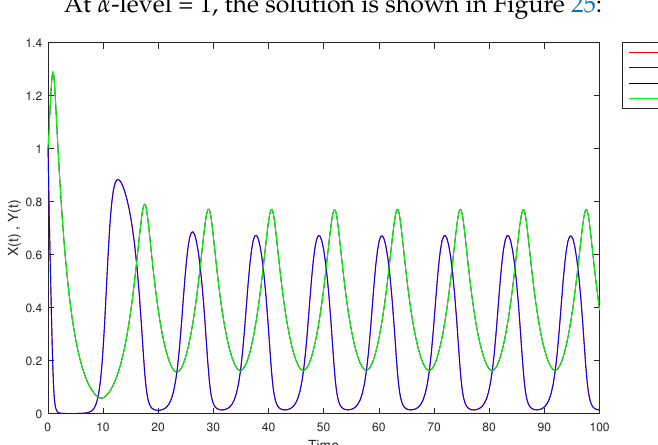
Figure 25. The solution of (12) at α =